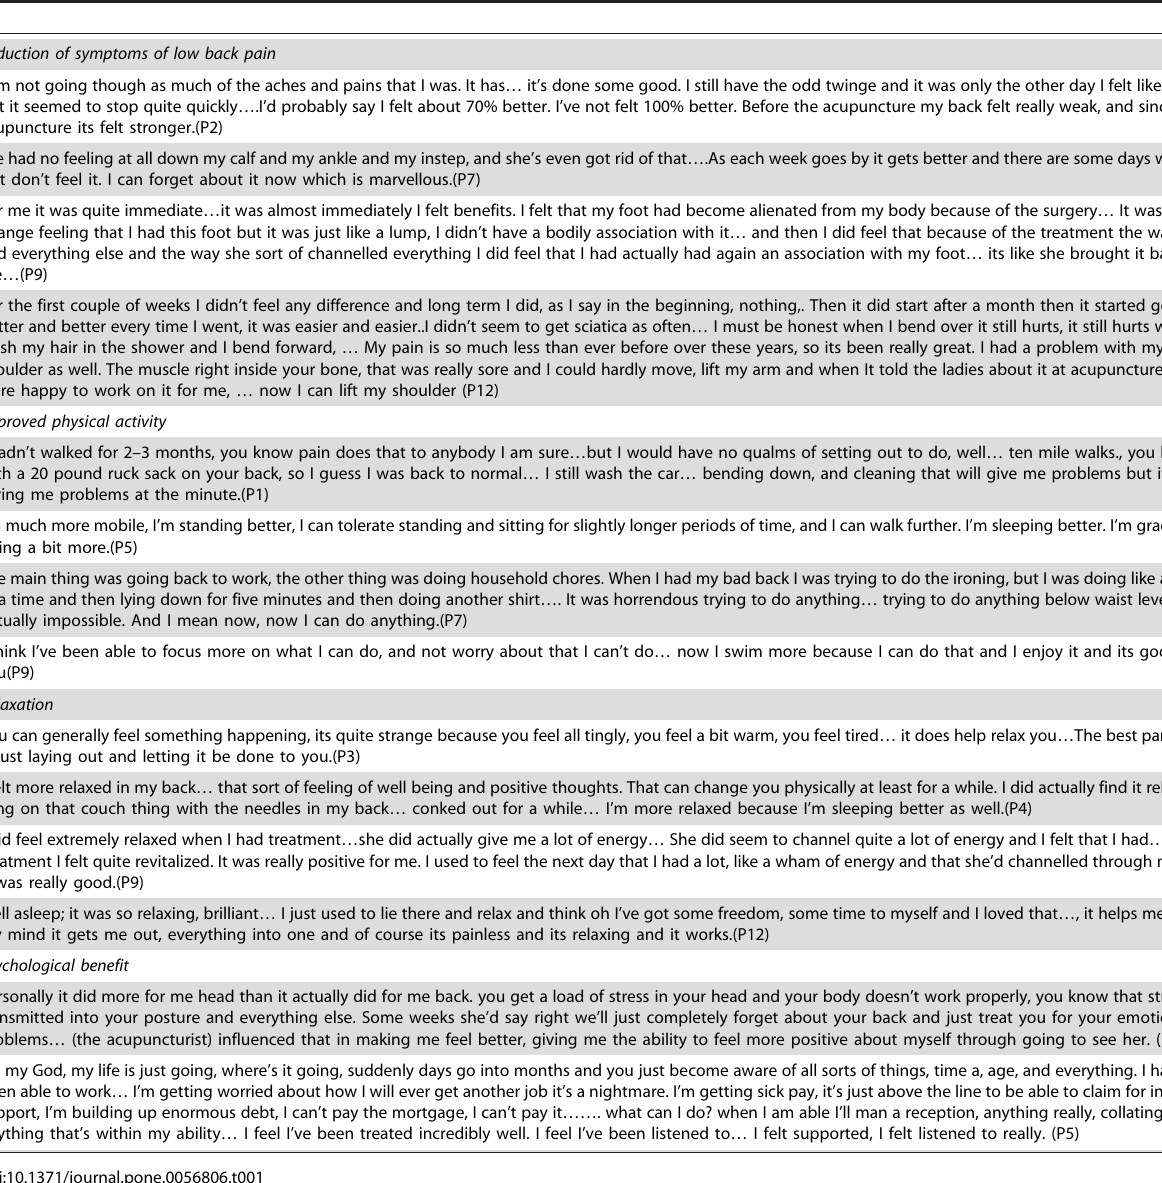
Table 1. Over-arching theme 1: Benefits of